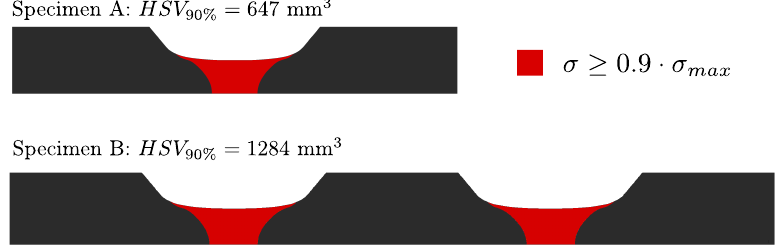
Figure 5. Finite Element (FE) analysis of specimens A and B with 90% HSV determined with C3D20R elements.